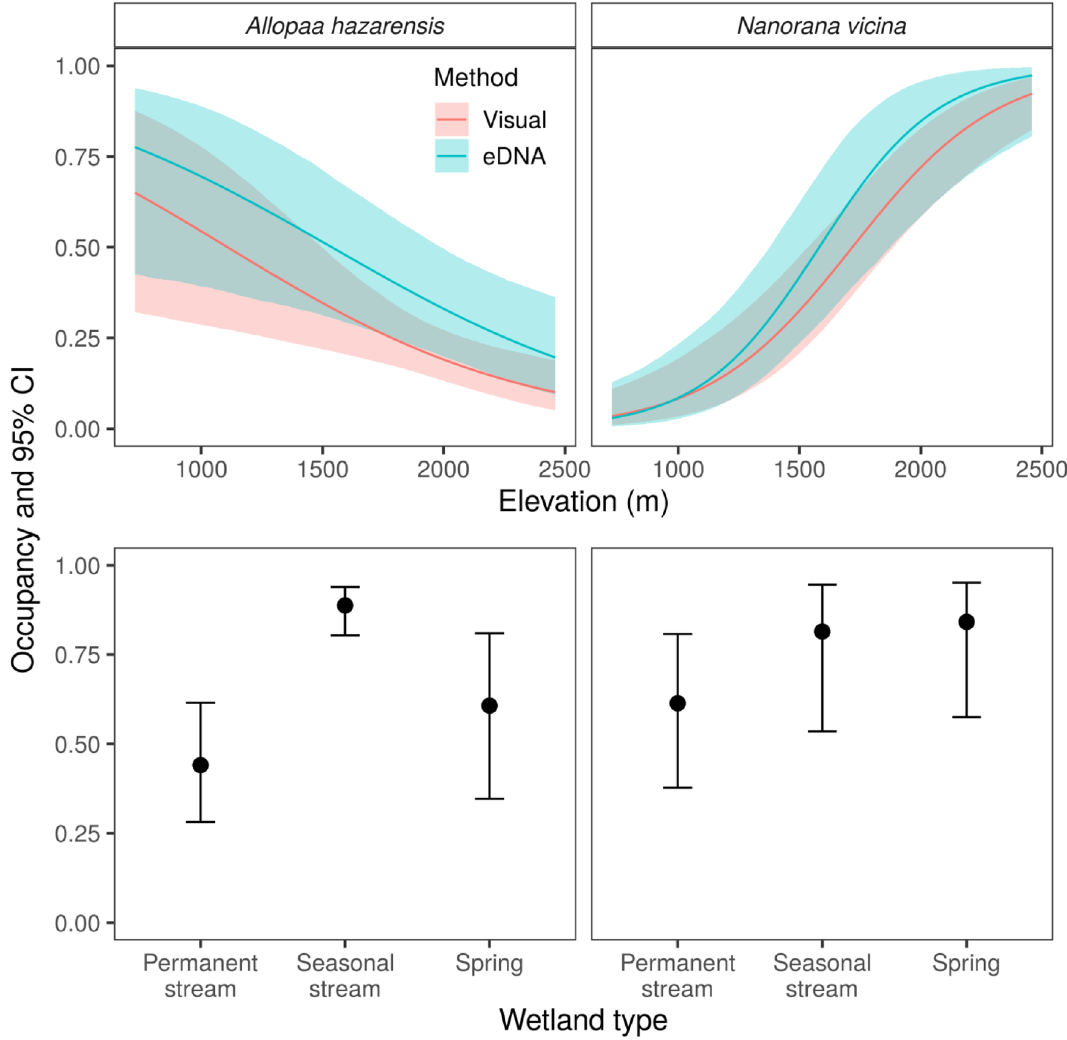
Figure 1. Top row: marginal effects of elevation on occupancy of the Hazara Torrent Frog ( Allopaa hazarensis ) and Murree Hills Frog ( Nanorana vicina ) based on multispecies occupancy models fit using visual observation and eDNA data. Bottom row: effect of wetland type on occupancy for the two frog species based on a multispecies model fit with eDNA data. Error bars and shaded areas represent 95% confidence